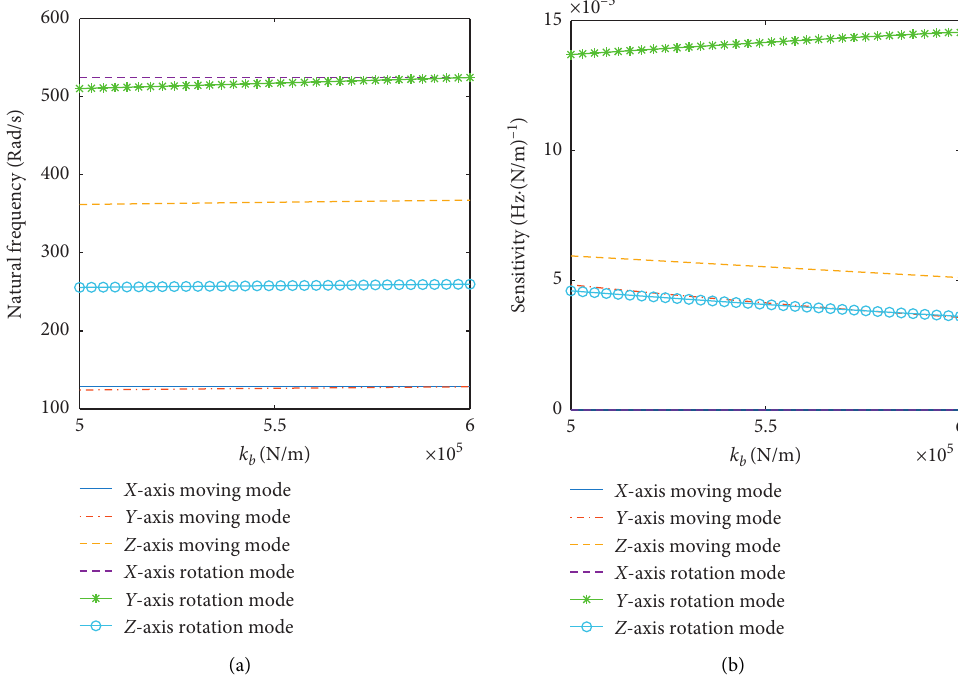
Figure 6: Curve of natural frequency and its sensitivity changing with the stiffness of outer leg 2. (a) Natural frequency. (b) Sensitivity of natural frequency to the stiffness of outer leg